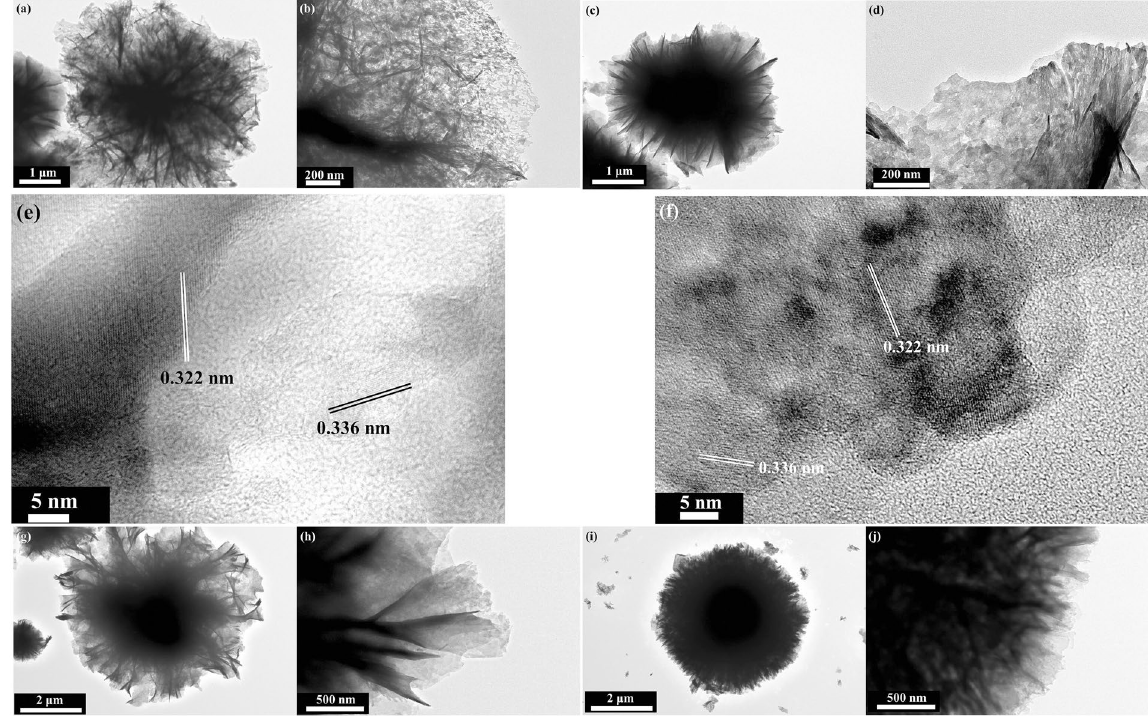
Figure 6. Typical TEM images of as-prepared samples with corresponding high magnification: ( a , b ) Cd-1, ( c , d ) Cd-2, ( g , h ) Cd-1-T4, and ( i , j ) Cd-1-T6. HRTEM images of as-prepared samples Cd-1 ( e ) and Cd-2 ( f ).